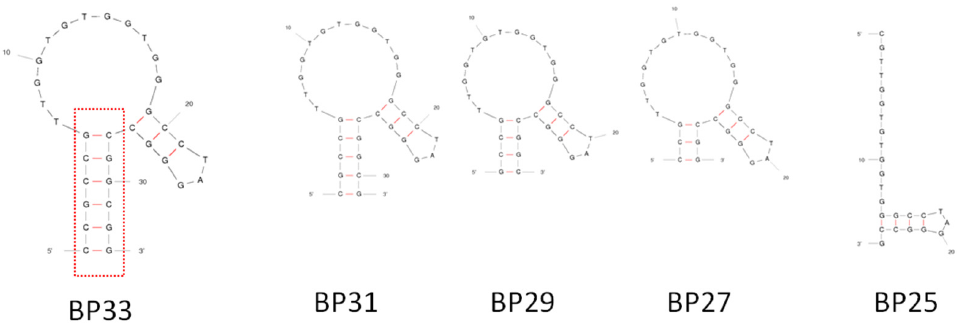
Figure 3. Predicted secondary structures of BP33 and its truncated aptamers.